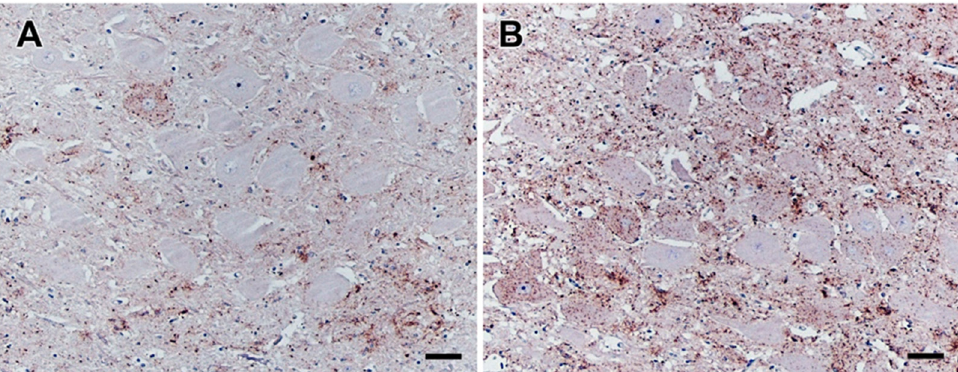
Figure 1. PrP BSE accumulation in the obex of positive control cattle. IHC results obtained for the obex from positive controls IC 01 (36 mpi; ( A )) and IC 04 (35 mpi; ( B )); ( A ): a single neuron revealing a intracytoplasmatic and perineuronal staining pattern as well as moderate fine granular PrP BSE accumulation in the neuropil of the dorsal motor nucleus of the vagus nerve (DMNV) of the obex from IC 01 (36 mpi); ( B ): intracytoplasmatic and perineuronal PrP BSE accumulation as well as mild to severe fine to coarse granular accumulation of PrP BSE in the neuropil of the DMNV of the obex from IC 04 (35 mpi); ( A , B ): Immunohistochemistry, PrP mAb 6C2, bar 50 µm.